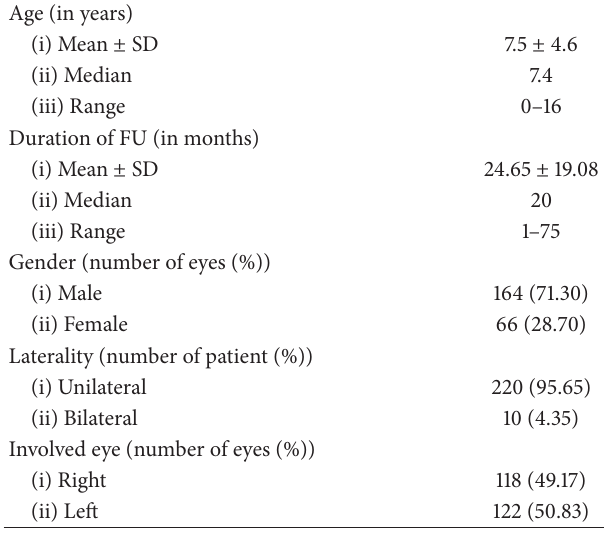
Table 2: Demographic features of 230 patients (240 eyes) with vitreous hemorrhage Number of eyes